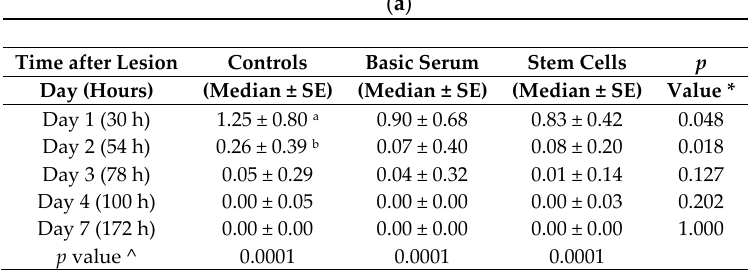
higher than the other groups.